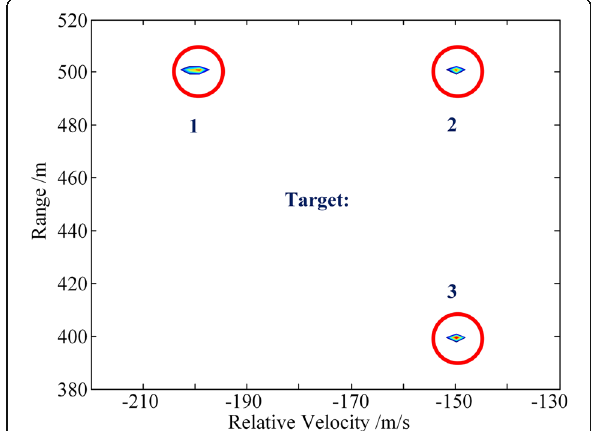
Fig. 9 – 6 dB sectional view of CE-OFDM RadCom system for three